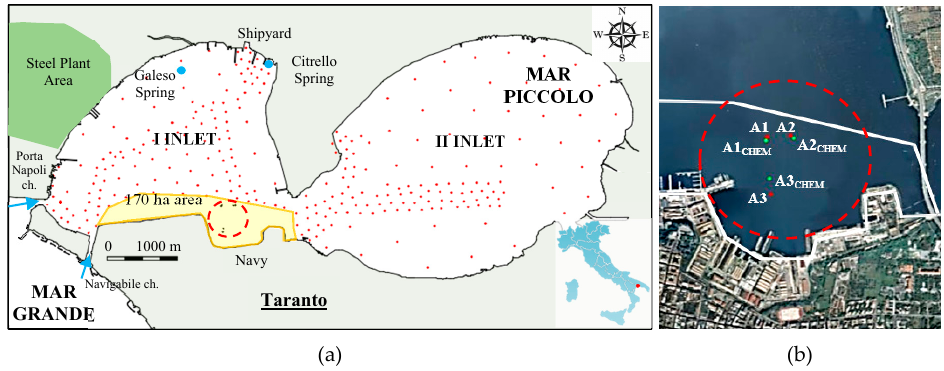
Figure 1. ( a ) Mar Piccolo basin in Taranto (Southern Italy) and map of the sampling sites. Red dots: ISPRA campaign (Institute for Environmental Protection and Research); dots in the circle: ARPA campaign (Regional Agency for Environmental Protection). ( b ) Location of the geotechnical ARPA boreholes (A1, A2, A3) and nearby chemical sites (A1 CHEM , A2 CHEM , A3 CHEM ) within the “170 ha area.”